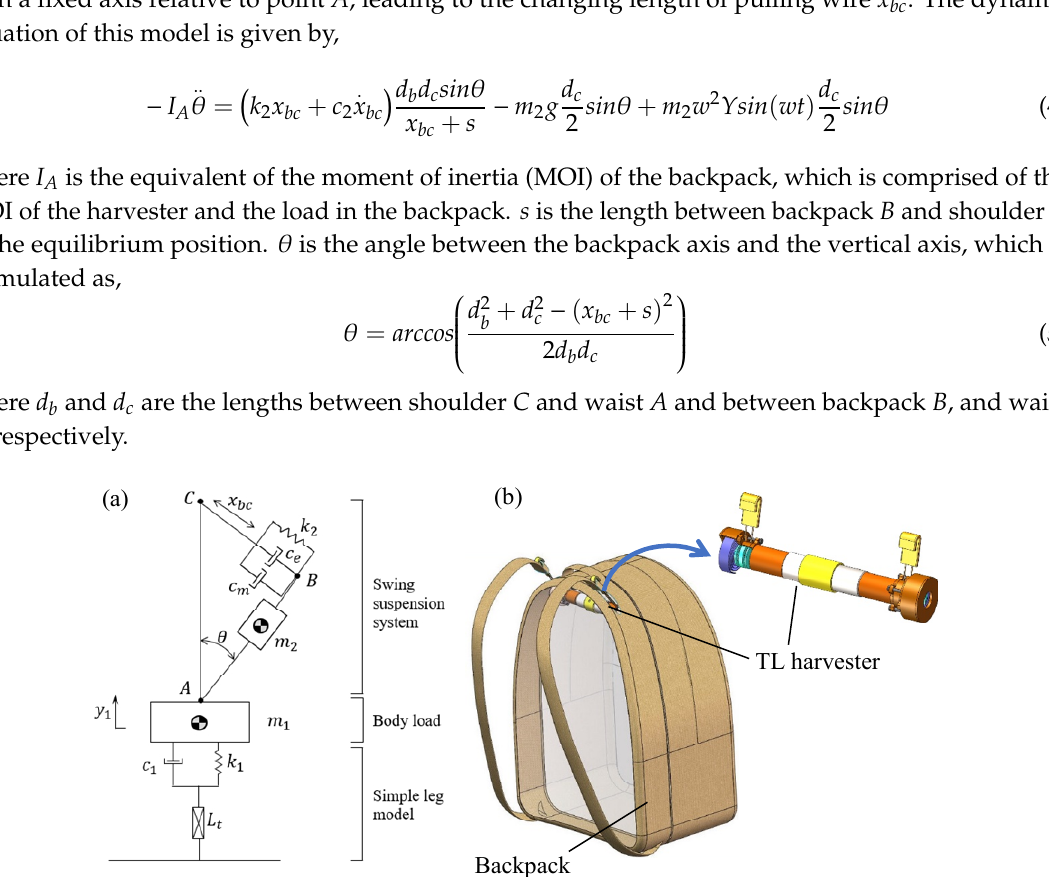
Figure 2. Schematic of the TL harvester: ( a ) Spring-mass-damper swing model; ( b ) TL energy harvester assembly mounted in the backpack [30] .